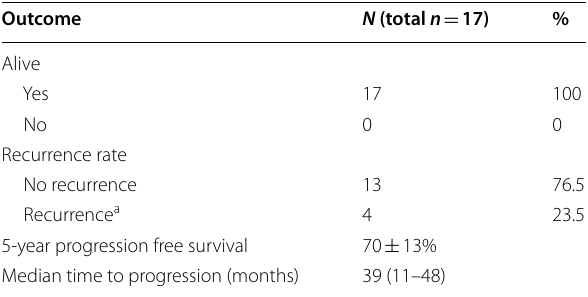
Table 2 Treatment outcome